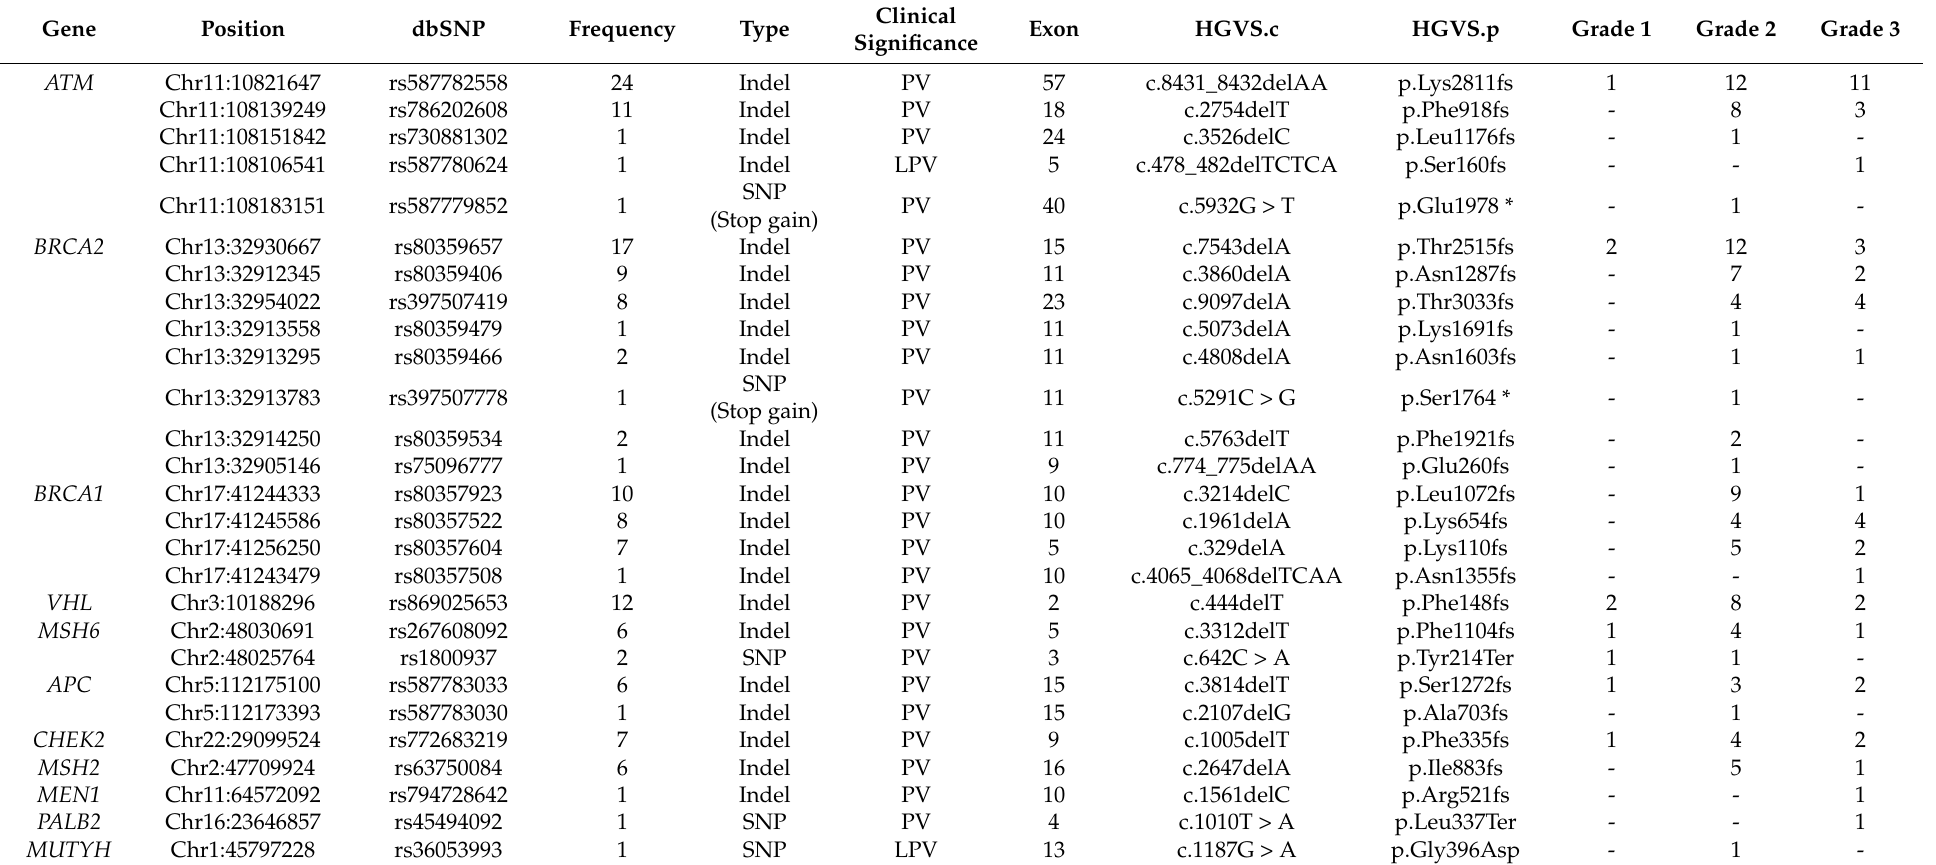
Table 2. List of pathogenic and likely pathogenic mutations identified with multi-gene panel